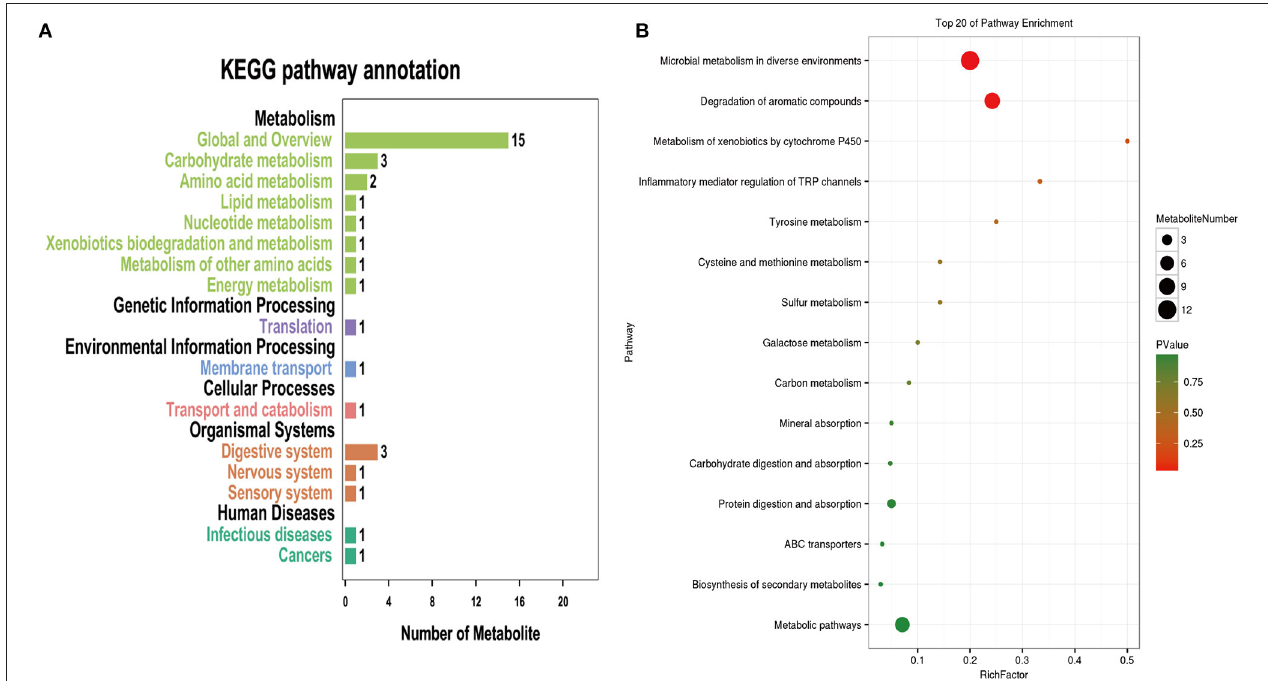
FIGURE 3 | Common metabolic pathways of characteristic VOCs and serum-specific metabolites in patients with CPA. (A) Pathway enrichment histogram of candidate metabolites. (B) Bubble diagram of pathway enrichment results of candidate metabolites. the P *value ranges from 0 to 1. The closer to zero, the closer the color is to red, indicating that the enrichment is more significant.